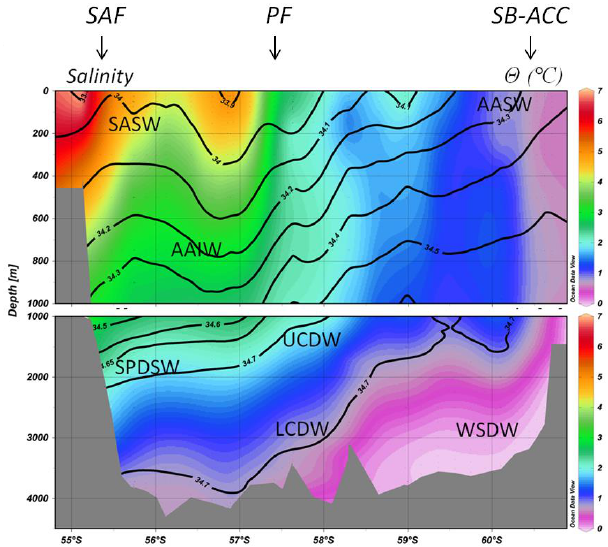
Fig. 2b. Potential temperature (color) and salinity (black contour lines) section of the Drake Passage transect. Approximate location of water masses and fronts (see text) is indicated.